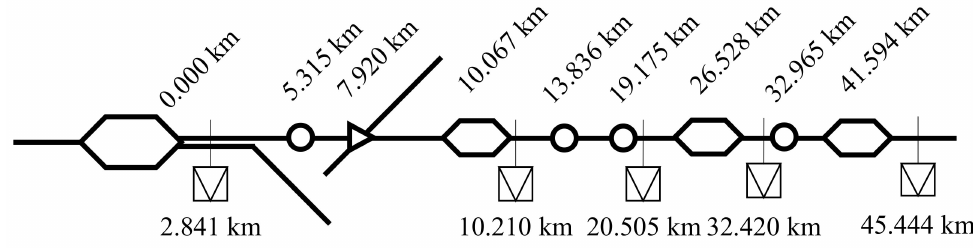
Figure 4. The schematic layout of the railway line we analysed.